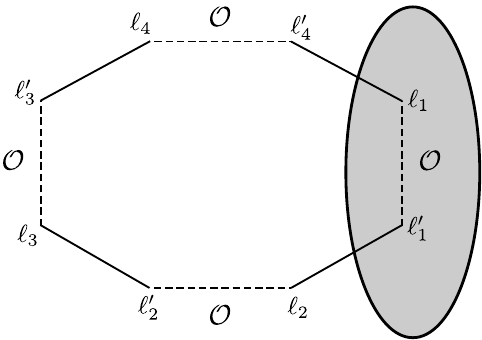
) . From the point i